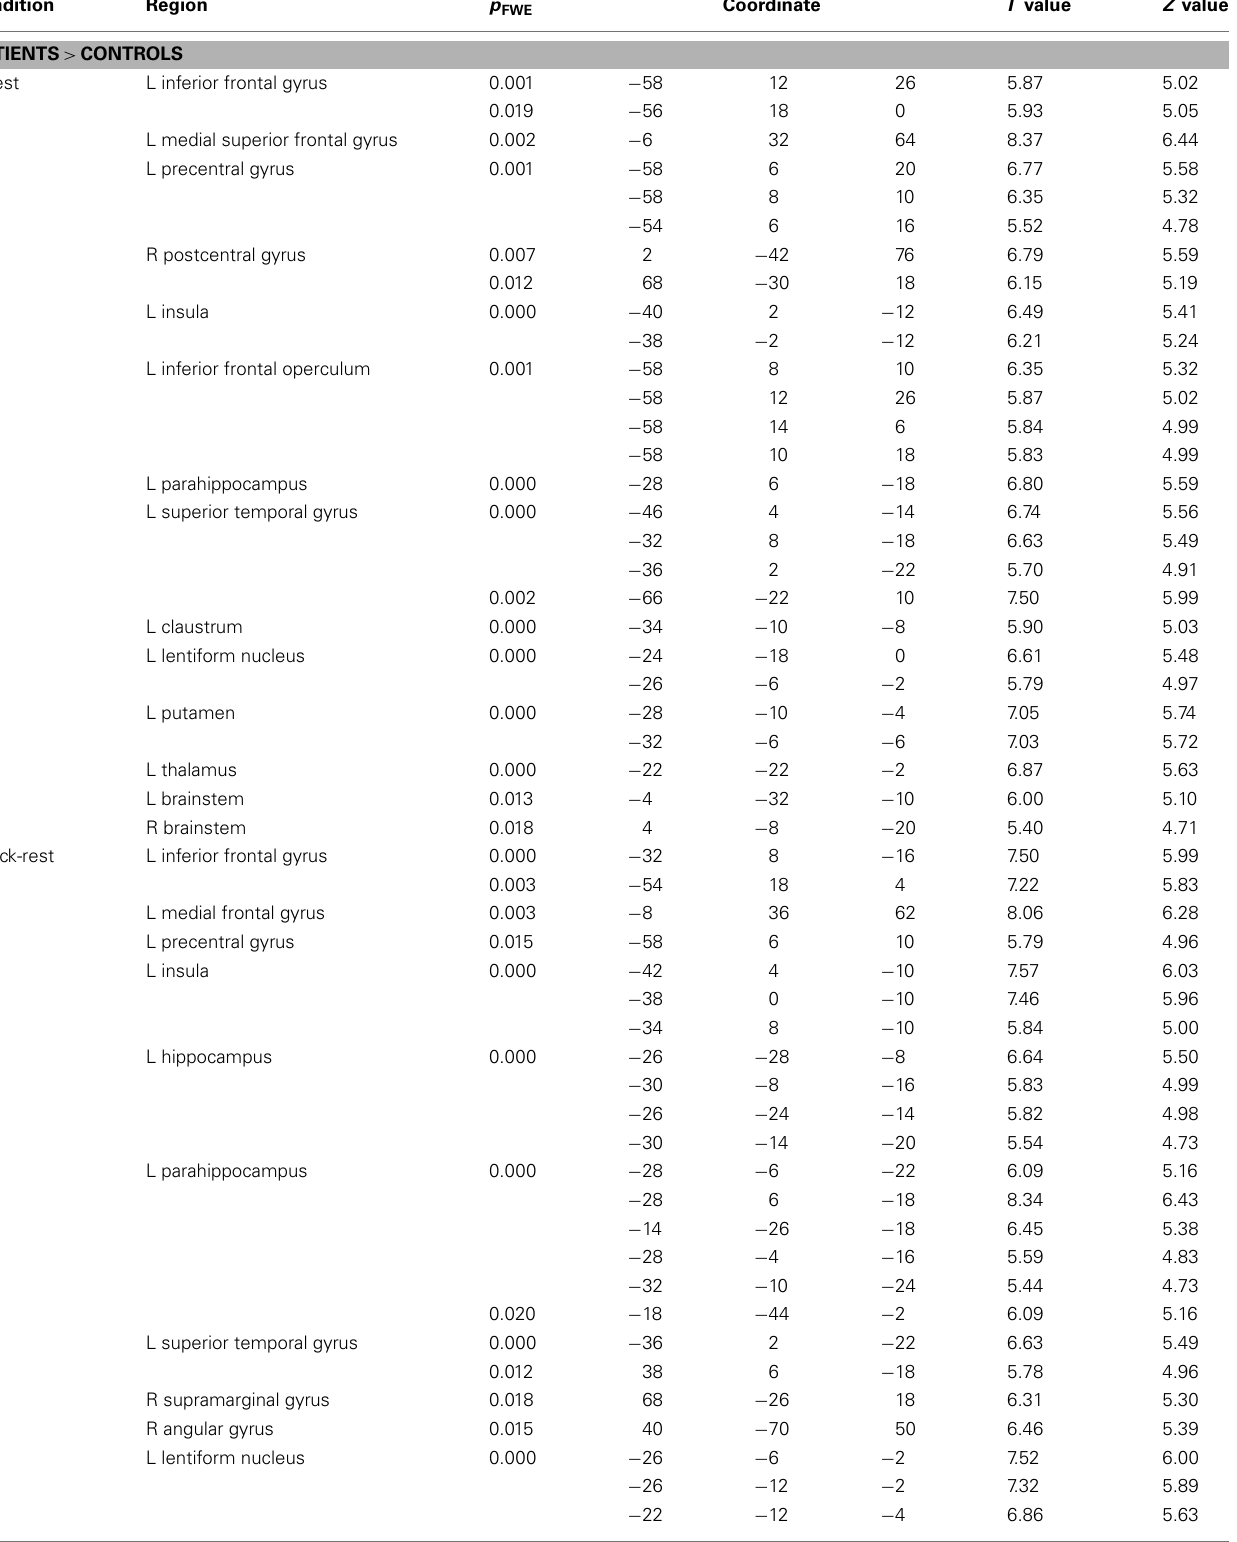
Table 4 | Significant flexible factorial results comparing patients and controls for the 2back-rest and 0-rest contrasts. Condition Region PATIENTS >